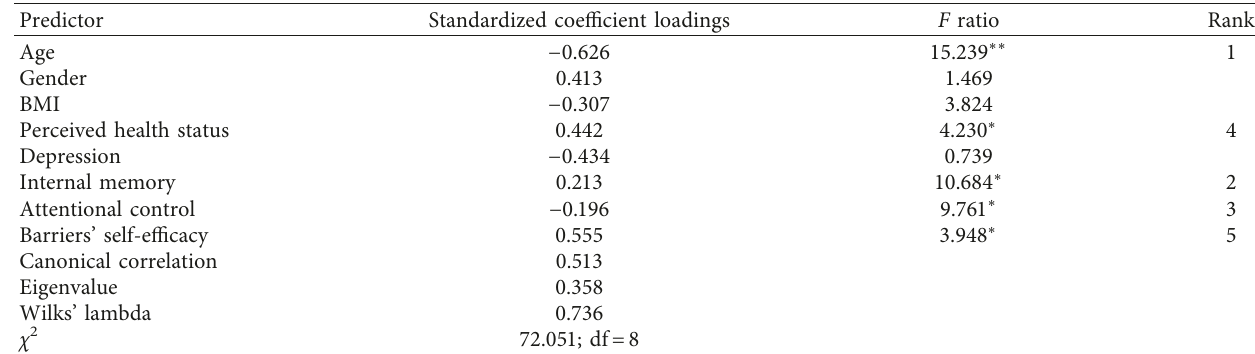
Table 3: Summary of interpretive measures for stepwise discriminant analysis.